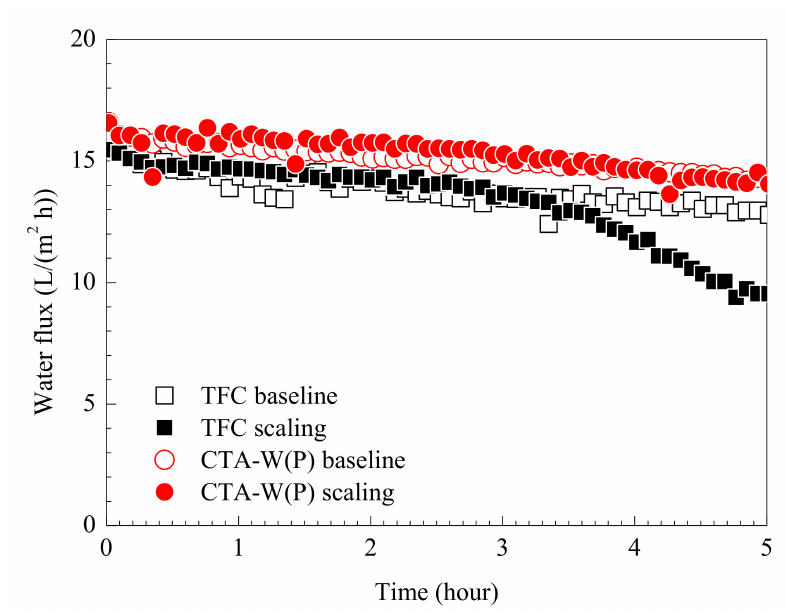
Figure 5. Water flux of TFC and CTA-W(P) in FO scaling tests. Testing conditions: FS for baseline tests was 0.163 M NaCl; FS for scaling tests was a mixed solution containing 72 mM Na 2 SO 4 , 26.1 mM CaCl 2 , and 10 mM NaCl; crossflow velocities of FS and DS on membrane were 23.2 cm/s; 2–3 M NaCl were used as DS to achieve initial water flux of 15 ± 1 L/(m 2